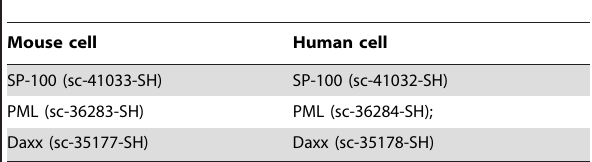
Table 1. shRNA plasmids used in this study.